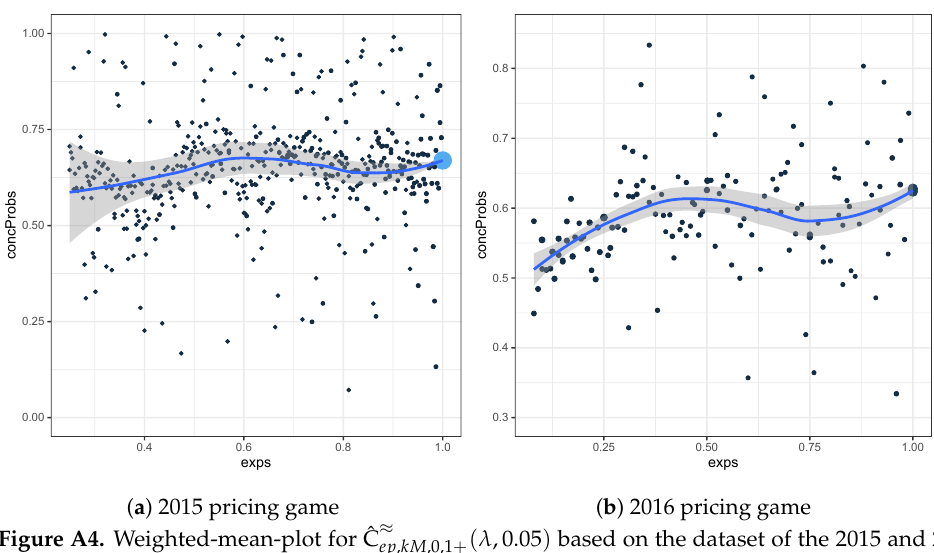
Figure A3. Weighted-mean-plot for ˆC pricing game. It is obtained by using 100 clusters for each group.